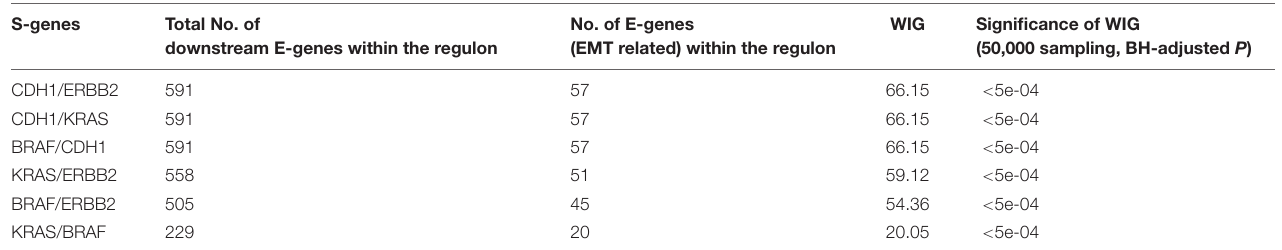
TABLE 2 | Double perturbations (kinase only) with top WIGs in GC. S-genes Total No. of downstream E-genes within the